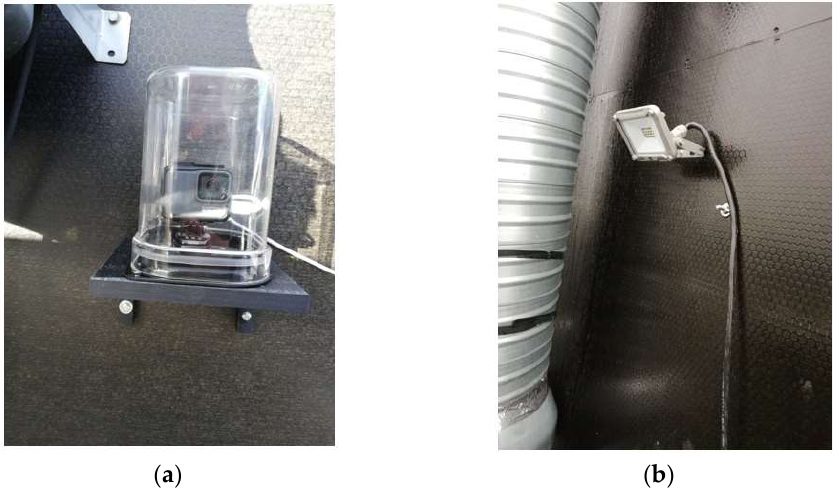
Figure 1. ( a ) A high-resolution camera for visually monitoring the surface of the evaporator; ( b ) the light source used during the nighttime.